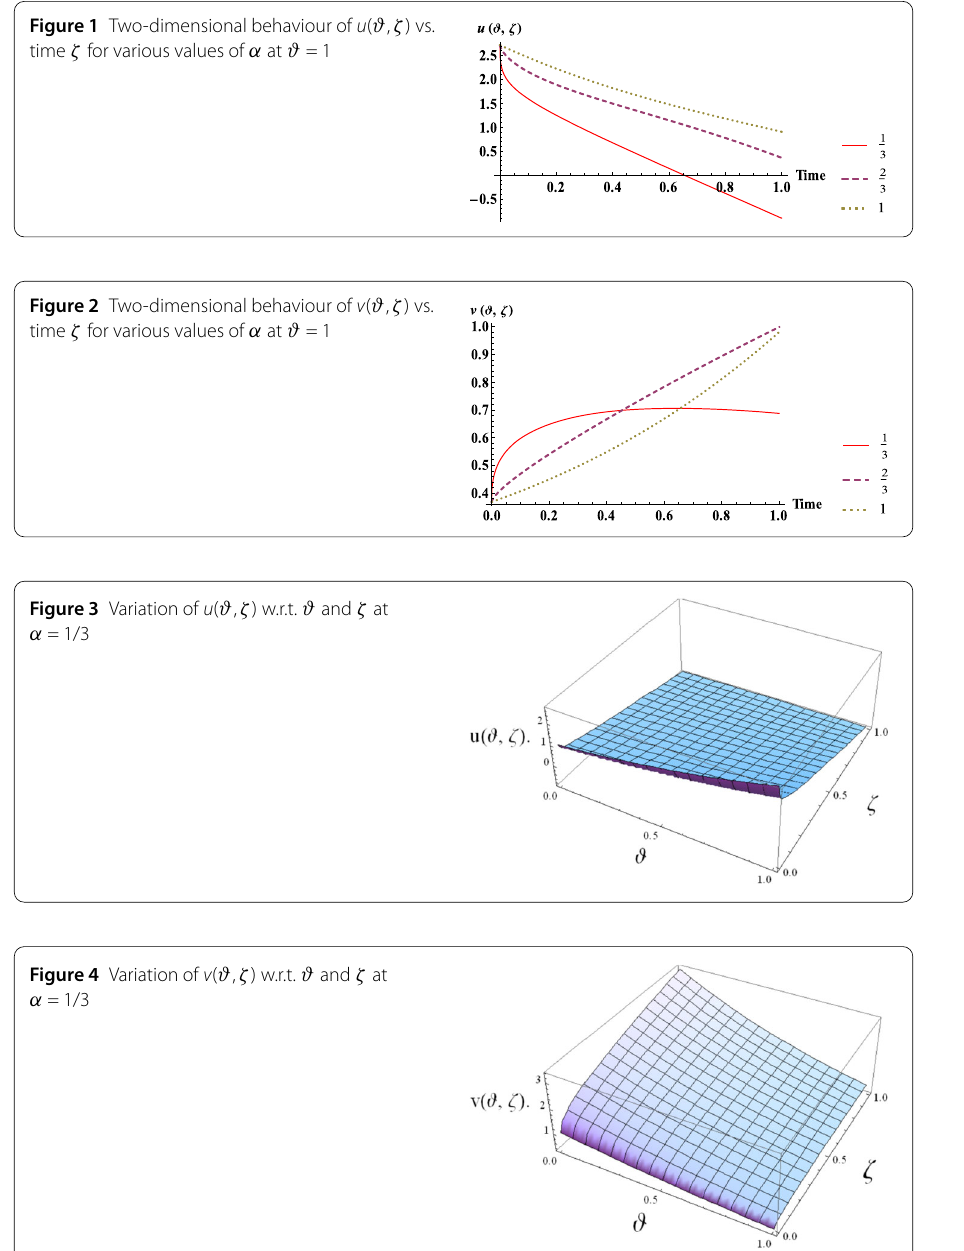
Figure 4 Variation of v ( ϑ , ζ ) w.r.t. ϑ and ζ at α =